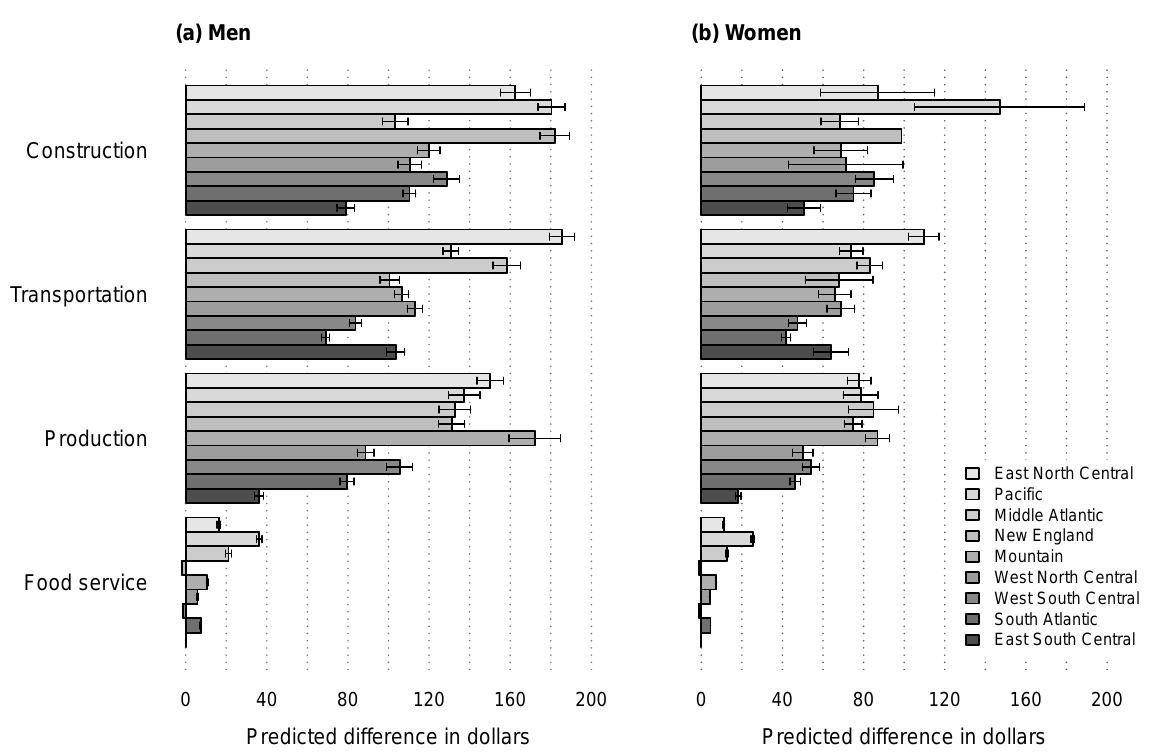
Figure 3: Predicted weekly wage differences for selected occupations and regions. Bars indicate the difference in dollars in 2015 between the model-predicted average weekly wages and the counterfactual wages for workers in each region within selected occupations. Lines denote 95% confidence intervals around those